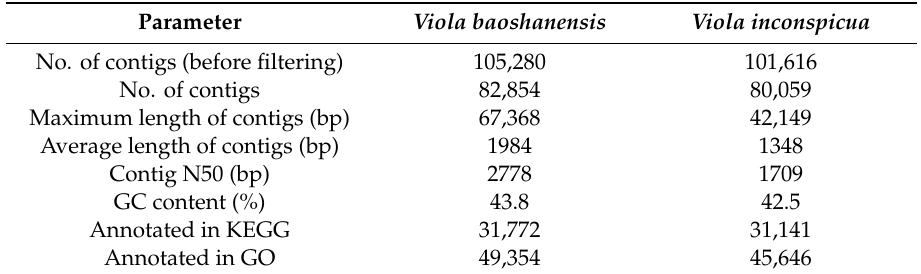
Table 1. Statistics of the assembling and annotation data for the transcriptomes of two Viola species. Parameter Viola baoshanensis Viola inconspicua No. of contigs (before